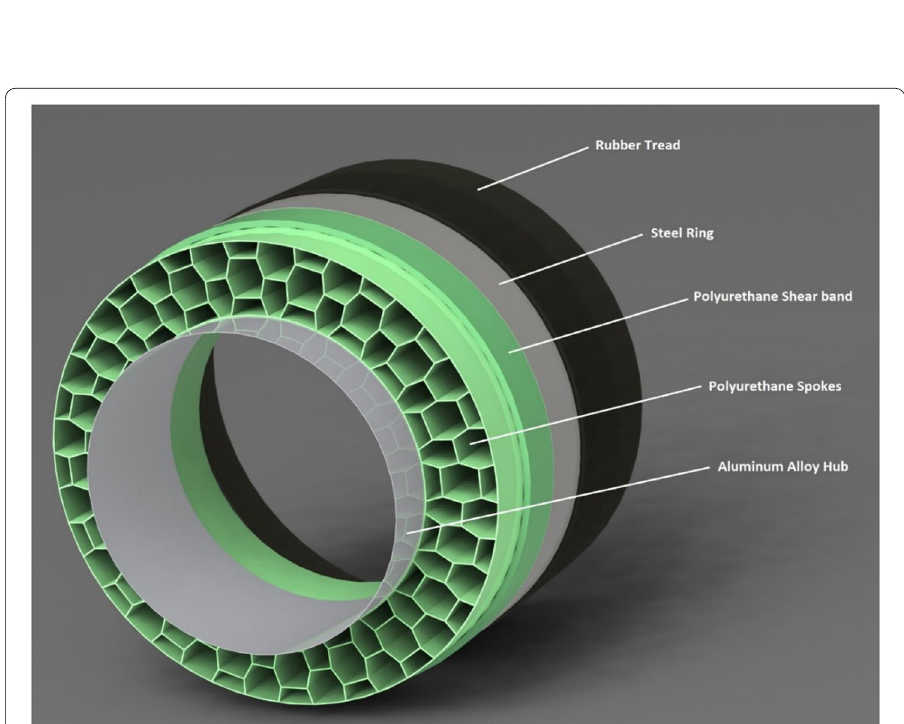
Fig. 1 Photo of NPT with all the components including honeycomb